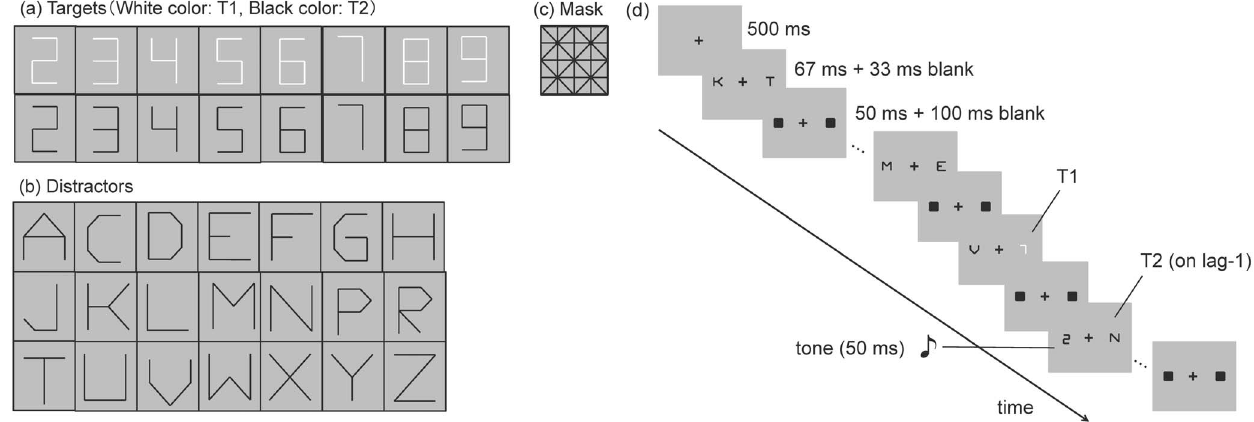
Figure 1. The visual stimuli and general paradigm used in the experiments. (a) Targets: Digits composed of line segments. White-colored digits were presented as T1, and black-colored digits were presented as T2. (b) Distracters: Letters composed of line segments (see Olivers & Van der Burg, 2008). (c) Mask stimulus: Grid pattern made from the same line segments used to make the targets and the distracters. (d) Outline of the general paradigm. T1 and T2 were presented randomly in the left (for half of the trials) or the right RSVP streams. T2 was presented at lag-1, lag-2 or lag-5 in Experiment 1A, and at lag-1, lag-3, or lag-5 in Experiment 1B. A tone was presented simultaneously with the onset of T2 in Experiments 1A, 2, and 3, and with either the onset of T1 or T2 in Experiment 1B. (With the permission from Japanese Psychonomic Society (JPS), reprinted with partially modified from Takeshima and Gyoba [60]).